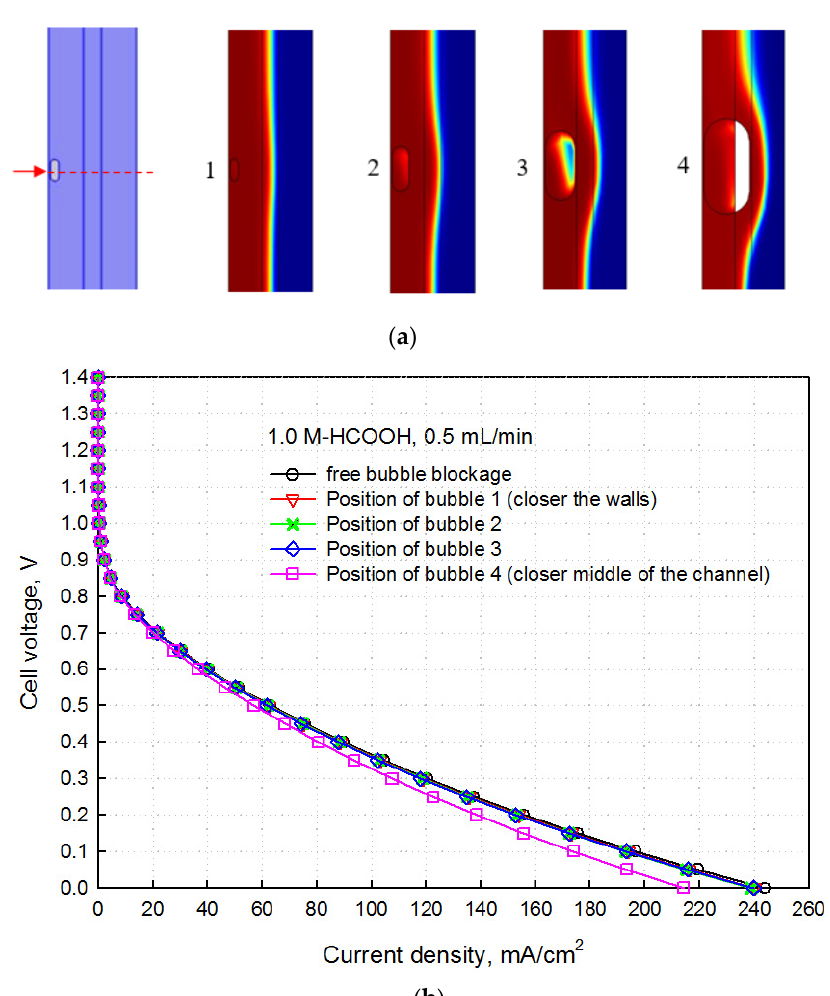
Figure 8. The simulation study of gas bubble growth: ( a ) The effect of blockages of different sizes on the fuel concentration distribution at 0.5 M-HCOOH at the volumetric flow rate of 0.7 mL/min; ( b ) The effect of blockage size on the I–V curve of the MFC at a fuel concentration of 1.0 M and volumetric flow rate of 0.5 mL/min.